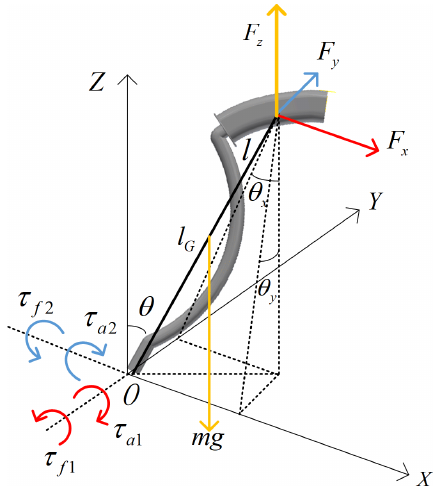
Figure 5. The proposed free-body